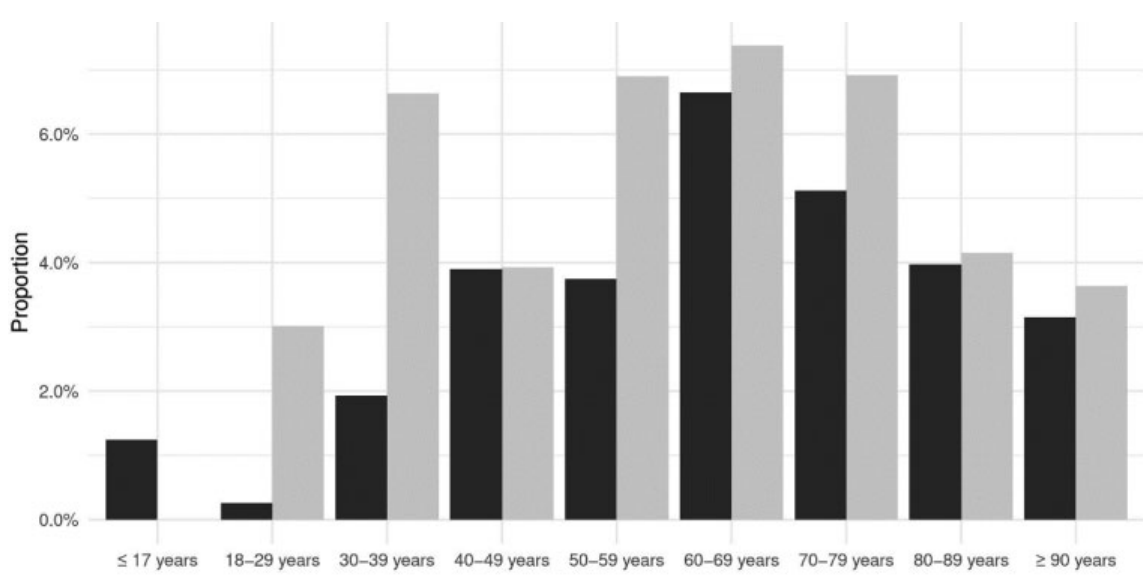
Fig. 1 Proportion of patients with at least one thromboembolic event in Covid-19 inpatients by age and